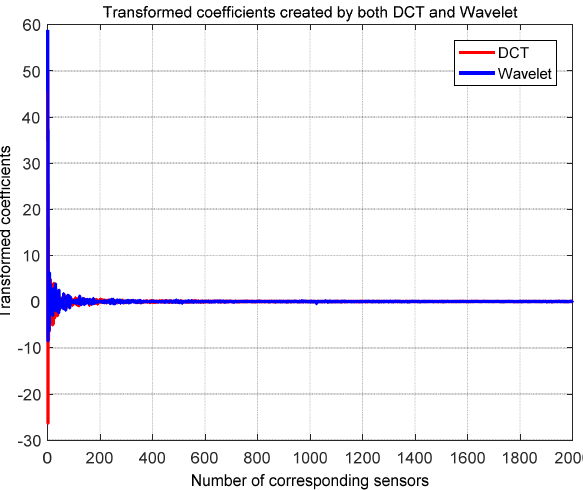
Figure 7. Temperatures collected from 2000 sensors randomly distributed in a sensing area